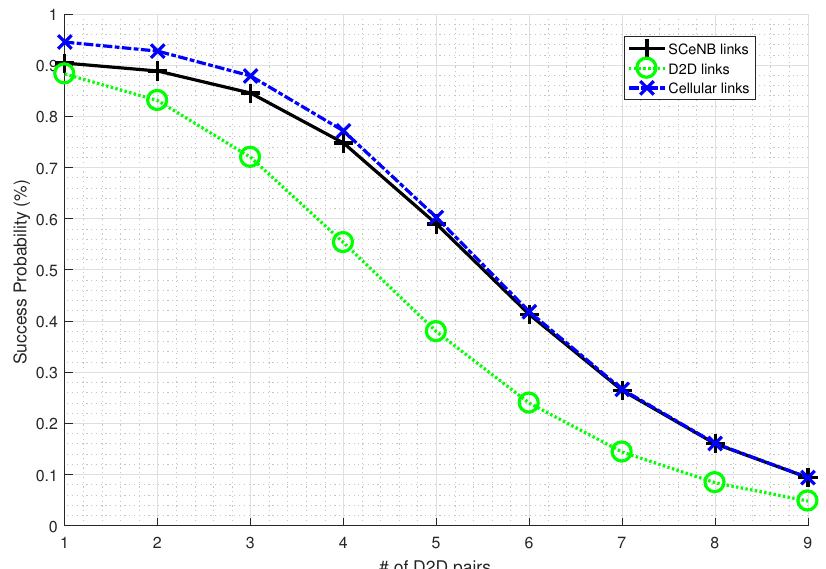
Figure 7. Success probability with small cell density.